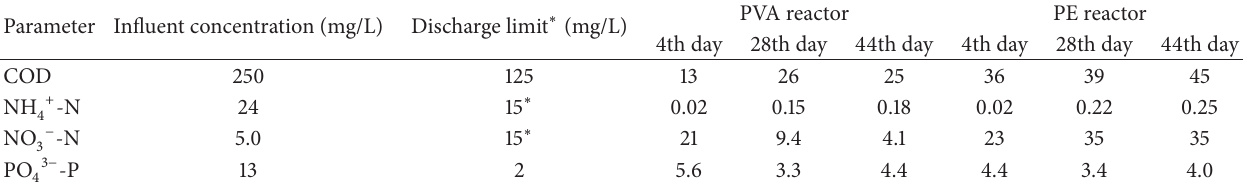
Table 1: Reactors effluent concentrations (mg/L) at 4, 28, and 44 days.